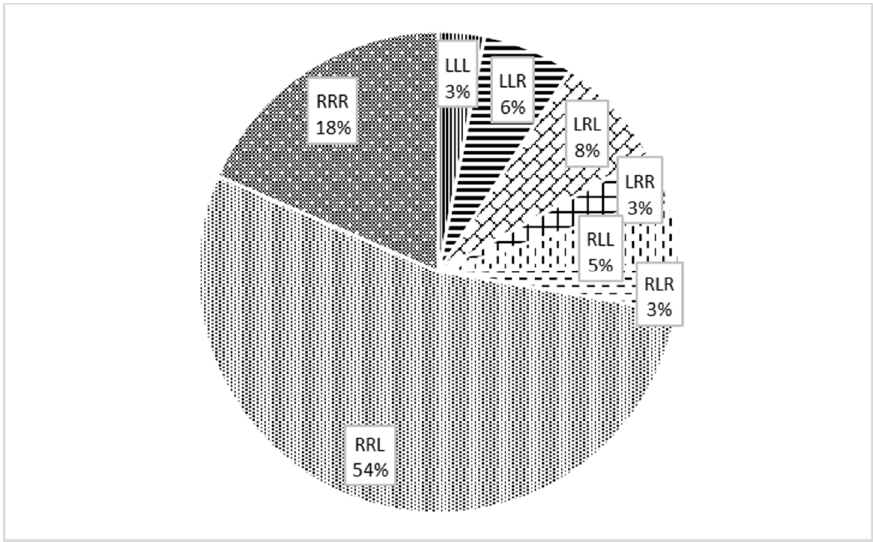
Figure 1. Percentage of representation of players by the preferred upper limb (writing), preferred lower limb (kicking) and take-off lower limb. 1st letter: which hand they use (L—left, R—right), 2nd letter: which leg they use for kicking, 3rd letter: which leg they use for take-off.